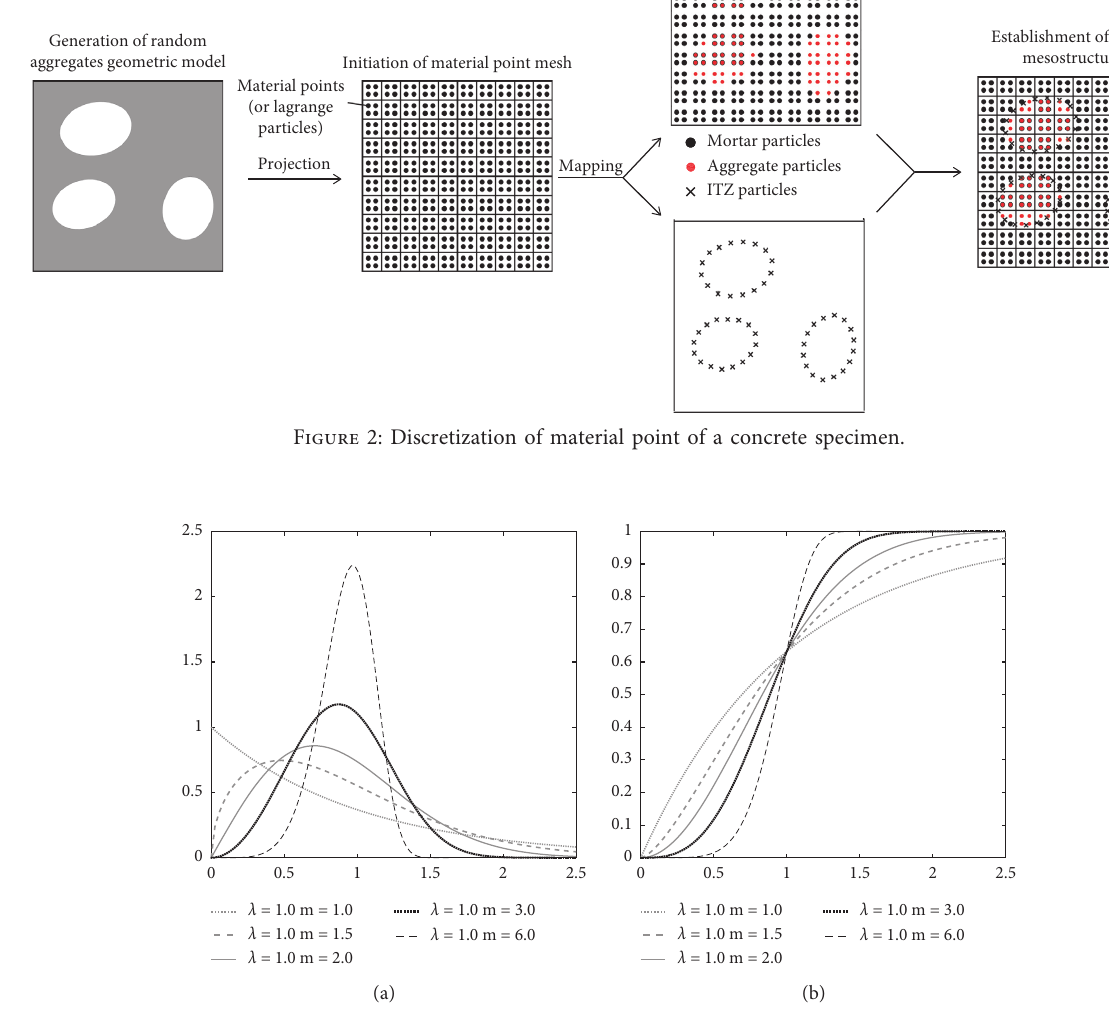
Figure 3: Probability density function and cumulative distribution function of Weibull